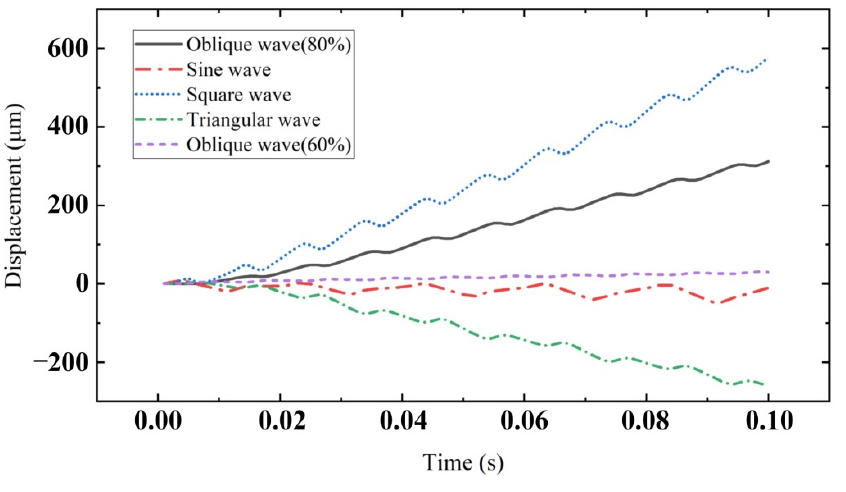
Figure 23. Displacement of mover under different voltage signal waveforms.